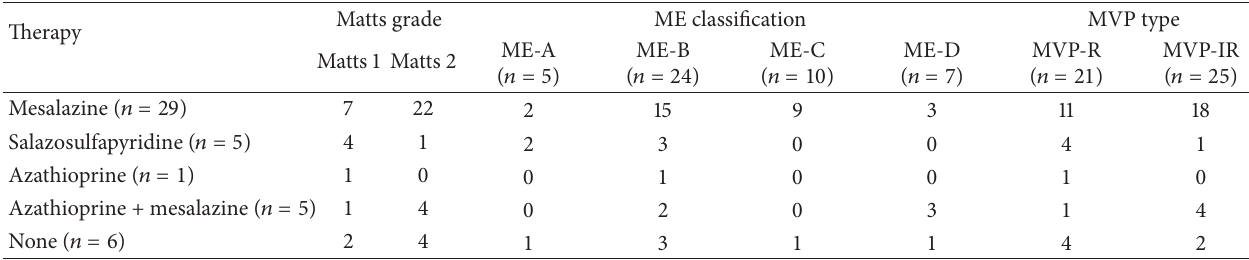
Table 1: Summary of relationship between ulcerative colitis treatment, Matts endoscopic grade, magnifying endoscopic (ME) classifications following crystal violet staining, and microvascular pattern (MVP). Matts grade ME classification MVP type Therapy Matts 1 Matts 2